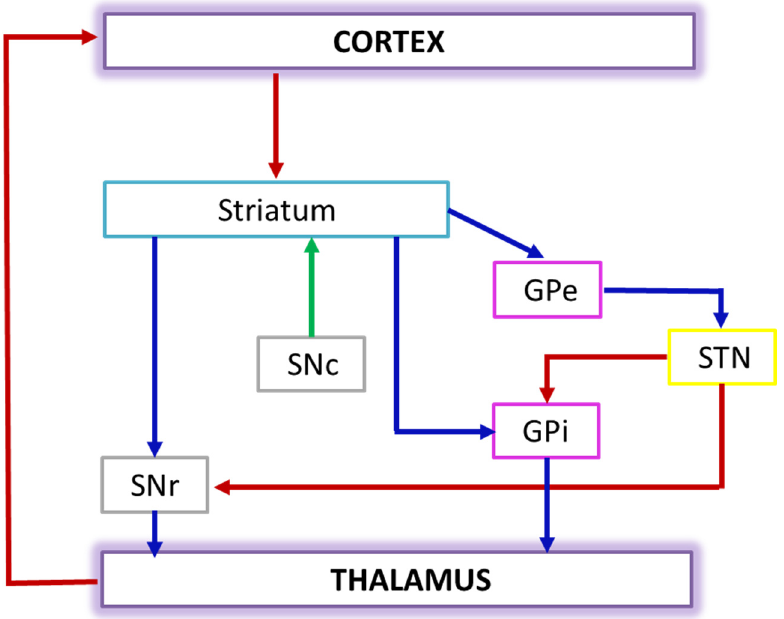
Figure 4. Dopaminergic pathways linking the basal ganglia and the cortex. Connectivity diagram showing excitatory glutamatergic pathways as red, inhibitory GABAergic pathways as blue, and modulatory dopaminergic as green. Their final functional output is the modulation of the cortical activity, mainly for motor-related circuits. Abbreviations: STN: subthalamic nucleus; SNr: substantia nigra pars reticulata; SNc: substantia nigra pars compacta; GPe: external segment of the globus pallidus; GPi: internal segment of the globus pallidus.